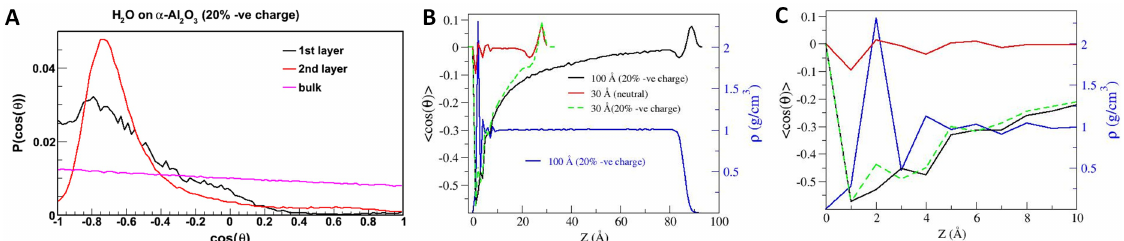
Figure 21. Effect of surface charge and thickness of water layer on the structuring of interfacial water at charged and neutral sapphire surfaces. ( A ) Shows the probability of the cosine of the dipole angle ( θ ) of water, measured with respect to the surface normal, for the first, and second water layers at a charged sapphire surface as well as for bulk water for comparison; ( B ) Shows time averaged cos( θ ) values for two different thicknesses of water at charged sapphire surface and a comparison with neutral sapphire surface. Also shown is the density distribution for 100 Å thickness of water on the charged sapphire surface; ( C ) Shows the zoomed in picture for the first 10